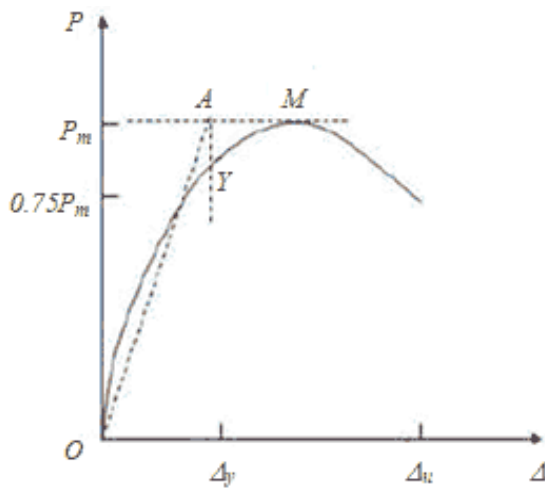
Figure 18. Ductility by secant stiffness method.